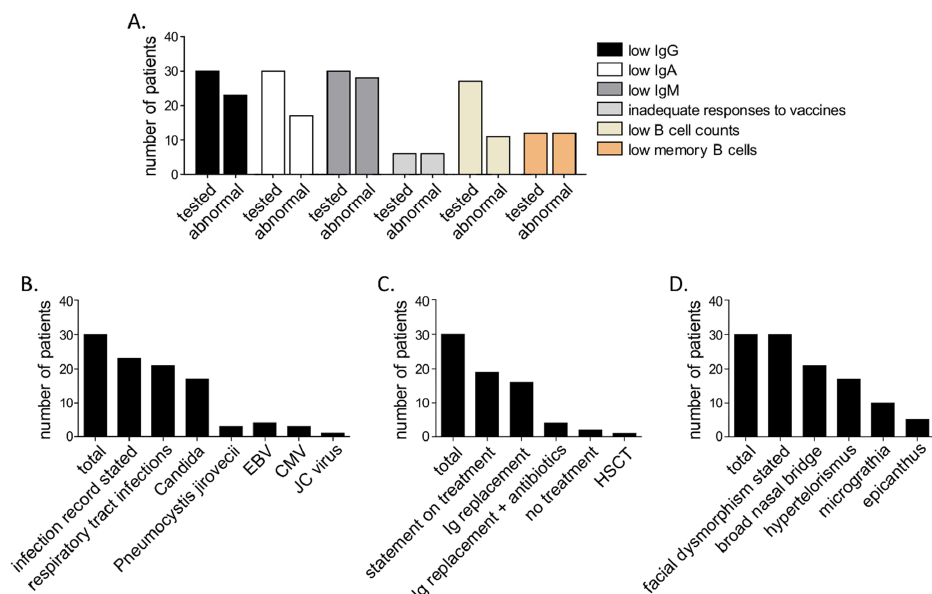
Figure 3. Summary of characteristics of all ( n = 30, including the here presented patients), so far reported patients with ICF2. ( A ) Summary of immunological findings, ( B ) Infections, ( C ) treatment reported patients with ICF2. A . Summary of immunological findings, B . Infections, C . treatment and and ( D ) facial D . facial dysmorphism.